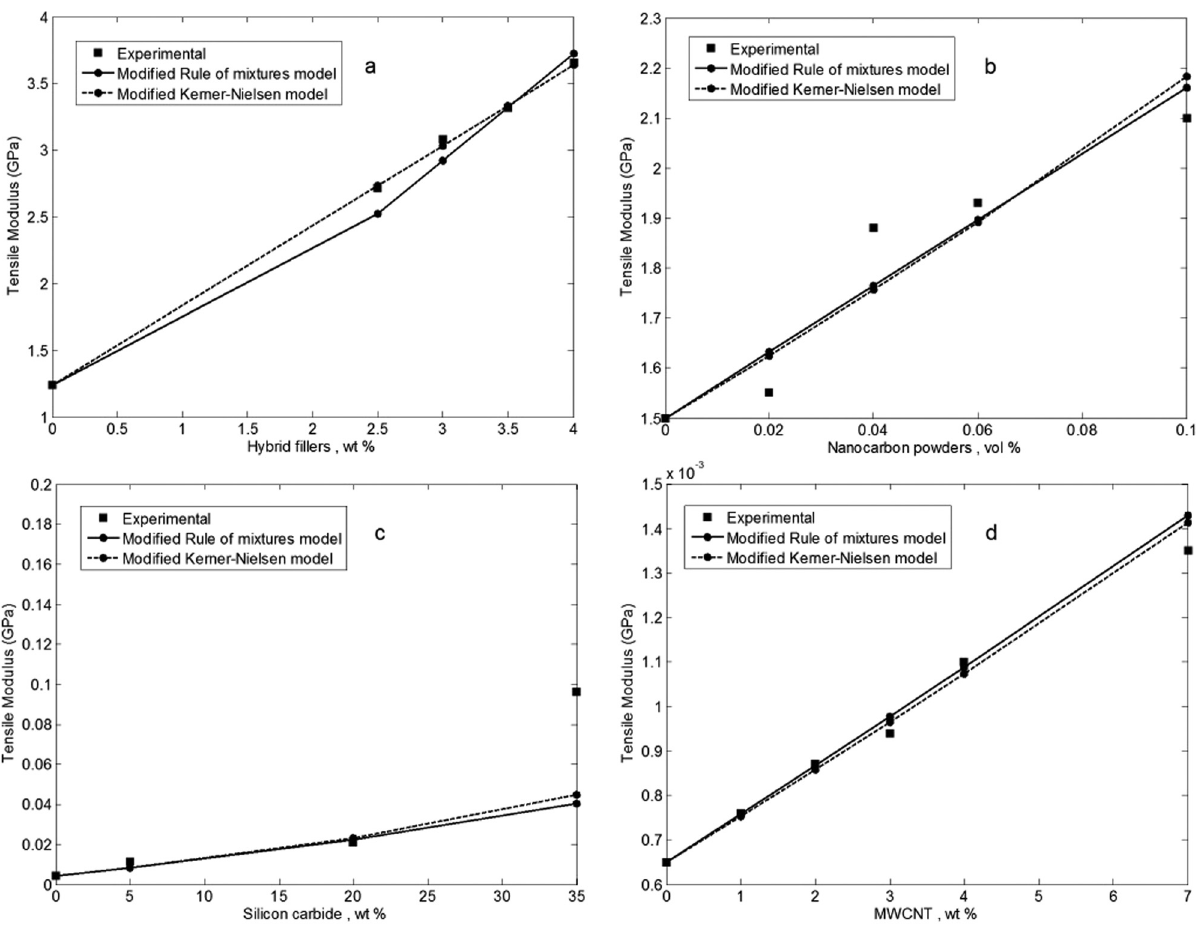
Figure 3: The obtained results by modi fi ed rule of mixtures and Kerner – Nielsen models for ( a ) PS/MWCNT/SCF ( No. 1 ) , ( b ) PS/nanocarbon powder ( No. 2 ) , ( c ) PU/silicon carbide ( No. 5 ) and ( d ) PDMS/MWCNT ( No. 7 ) samples.